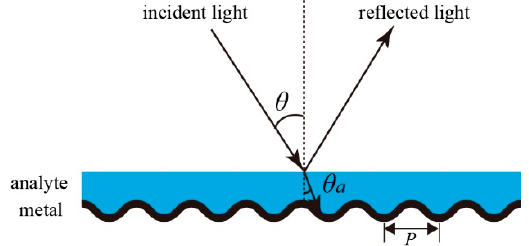
Figure 1. Schematic diagram of the grating-based surface plasmon resonance (SPR) sensor.